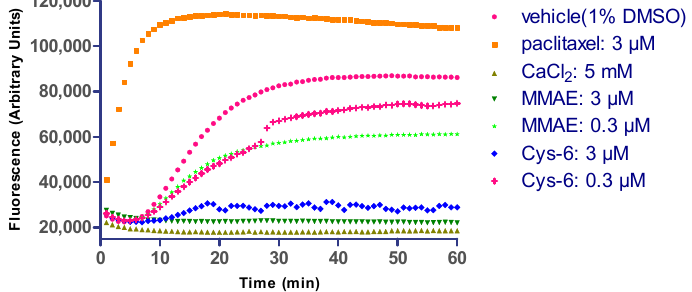
Figure 6. The inhibition tests of microtubule polymerization. The cytotoxin MMAE and the Cys- linker-MMAE (Cys-6) were tested in a microtubule polymerization assay. Free MMAE was included as a positive control. Paclitaxel and CaCl 2 were included as a promoter and inhibitor, respectively, of microtubule polymerization. The buffer control indicates the polymerization rate of untreated microtubules.